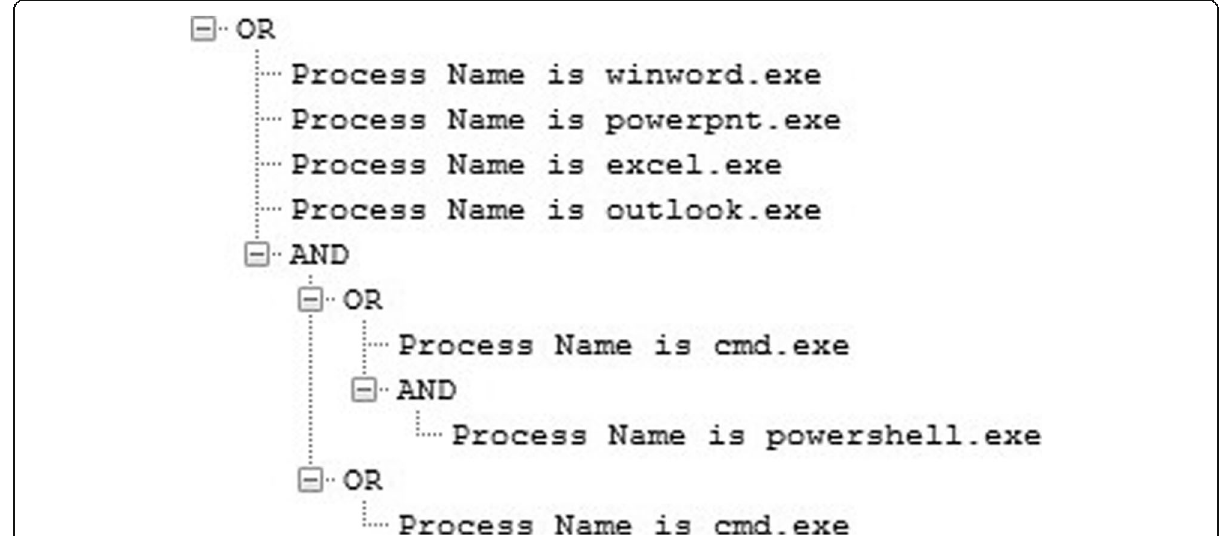
Fig. 3 Malicious process flow